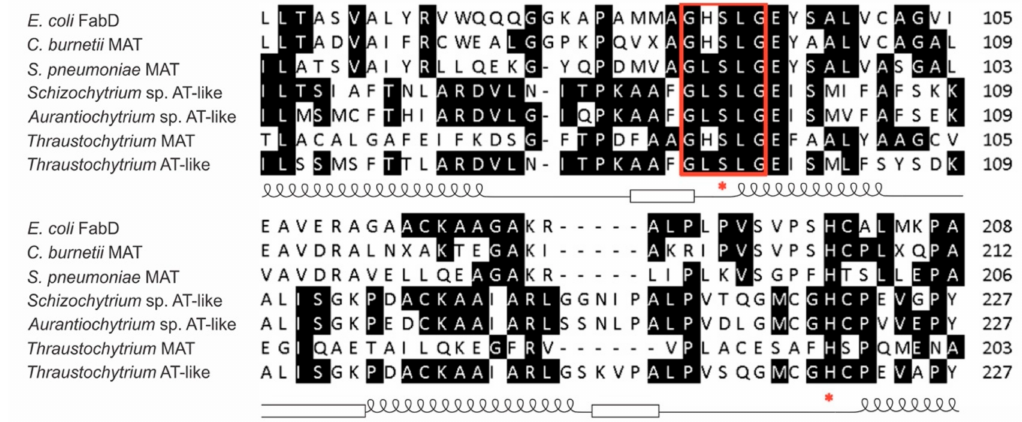
Figure 1. Partial sequence alignment of the acyltransferase (AT)-like domain of the polyunsaturated fatty acids (PUFA) synthase from Thraustochytrium with related sequences from other microorganisms. The AT-like domain has 343 amino acids in length located from amino acid 1048 to 1390 in subunit-B of the PUFA synthase. Here showed only the highly conserved region of AT-like sequence from amino acid 70 to 109 and from 188 to 227 of the 343 amino acids. The predicted α helices (coil) and β strands (square) of the partial α / β hydrolase fold were marked along the sequence. PUFA synthases from Schizochytrium (accession no. AAK72880.2, UniProt no. Q94FB7-1) and Aurantiochytrium (accession no. AIJ293323.1, UniProt no. A0A076NB29) as well as discrete malonyl-CoA:ACP acyltransferase (MATs) from Escherichia coli (accession no. 1mla, UniProt no. P0AAI9), Coxiella burnetii (accession no. 3tqe, UniProt no. Q83E39), and Streptococcus pneumoniae (accession no. 3im8, UniProt no. Q8DR16) were used in the alignment. The motif GXSXG is highlighted and the conserved serine and histidine residues are depicted by red asterisk.